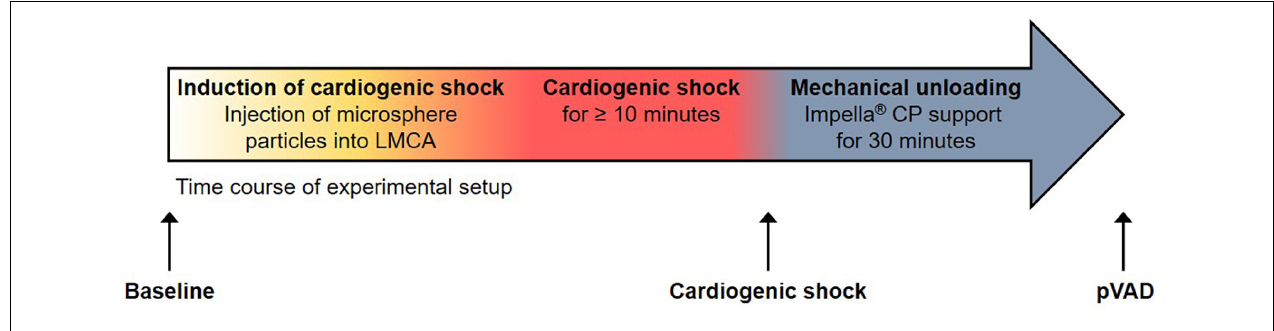
FIGURE 1 | Experimental setup. Time course of experimental setup with induction of cardiogenic shock and percutaneous ventricular assist device (pVAD) support by Impella R (cid:13) CP. Serum samples were collected at the time points denoted by black arrows. Note that the time point “pVAD” refers to pVAD support in the presence of cardiogenic